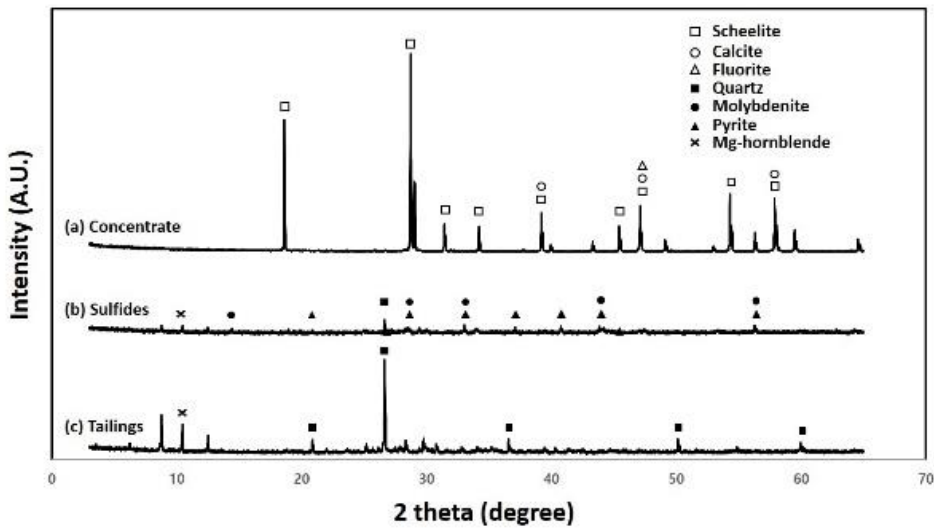
Figure 6. Schematic diagram of the selective depressing mechanism using sodium carbonate on the Ca-bearing mineral surface for recovery of scheelite .